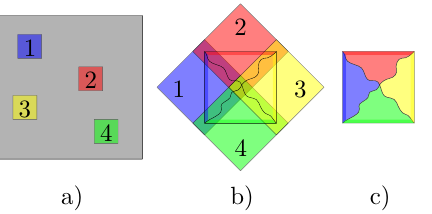
Figure 6. Automatic Tile Design [5], a) cut-outs for stapling, b) stapling, c) new tile.